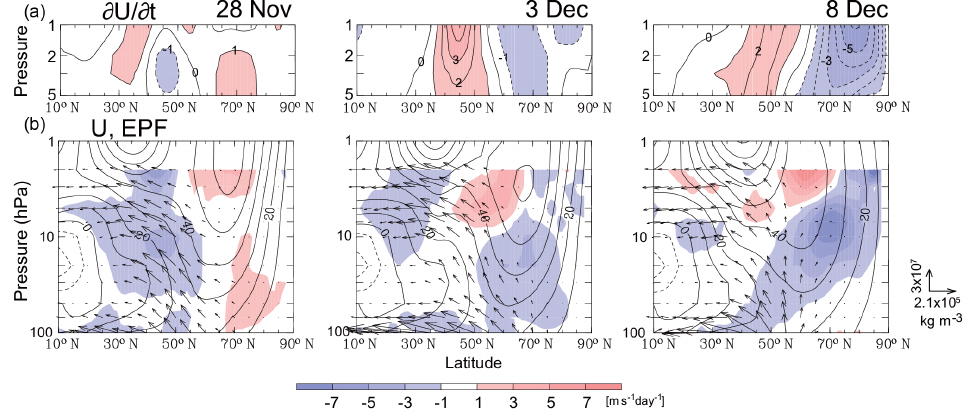
Figure 4. (a) Zonal-mean zonal wind tendency [ms − 1 day − 1 ]. (b) E–P flux (arrows) and zonal-mean zonal winds (contours) that are 5- day-averaged. E–P flux divergences are also shown using colour shading. The dates from left to right (28 November, 3 December, and 8 December) are the middle days of the 5-day mean.